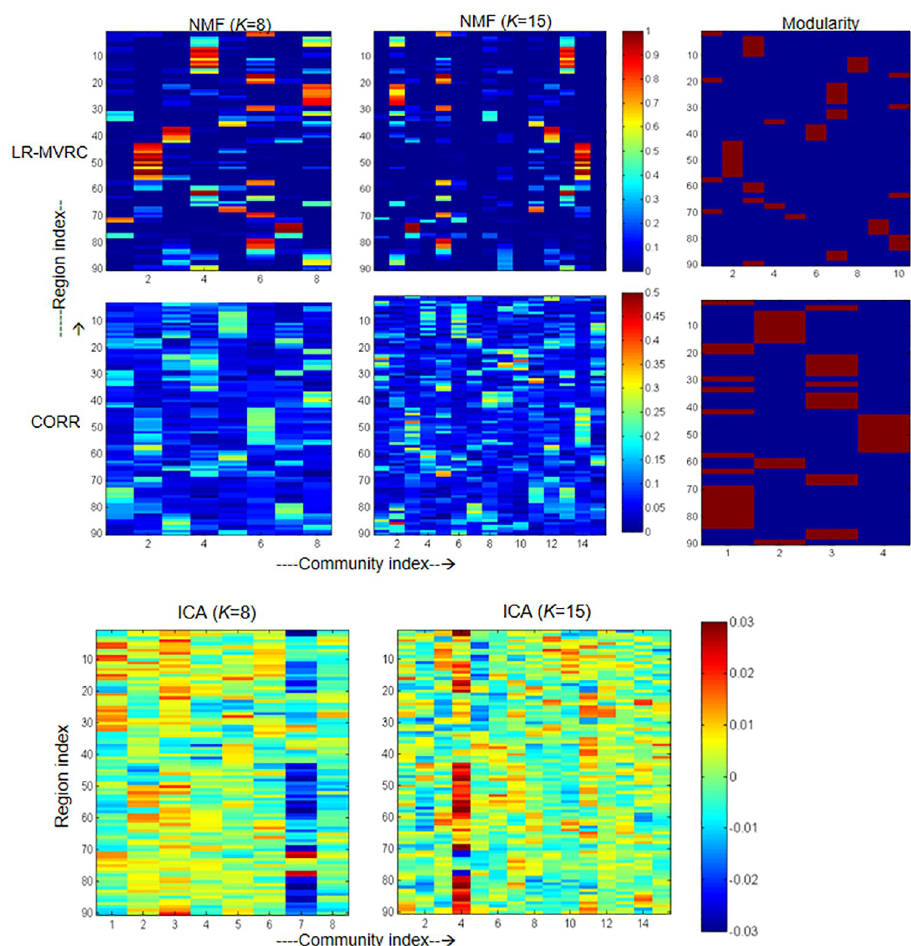
Fig 1. First row : Community structure obtained using LR-MVRC and CORR matrices with NMF and modularity optimization methods . Second row : Community structure obtained using ICA with K = 8 and 15 in the first and second columns, respectively . In the first row, first two columns represent the matrix P obtained from LR-MVRC and CORR with K = 8 and 15 in NMF, respectively. The third column represents modularity optimization results on both LR-MVRC and CORR based adjacency